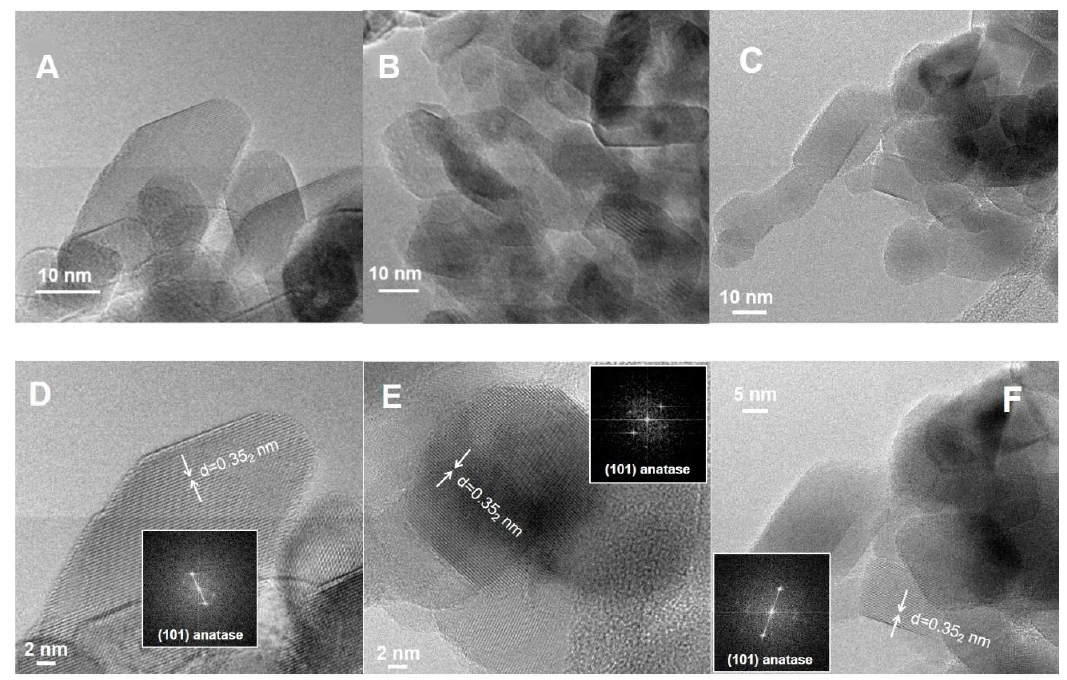
Figure 1. HR-TEM images and related Fourier Transform of selected nanoparticles for TiO 2 SX001 (panels A and D ), PC105 (panels B and E ) and P25 (panels C and F ).